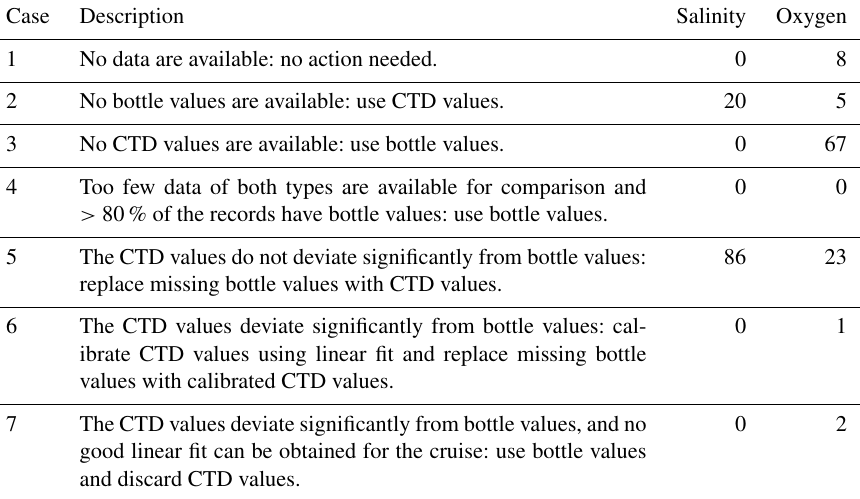
Table 4. Summary of salinity and oxygen calibration needs and actions; number of cruises with each of the scenarios is identified. Case